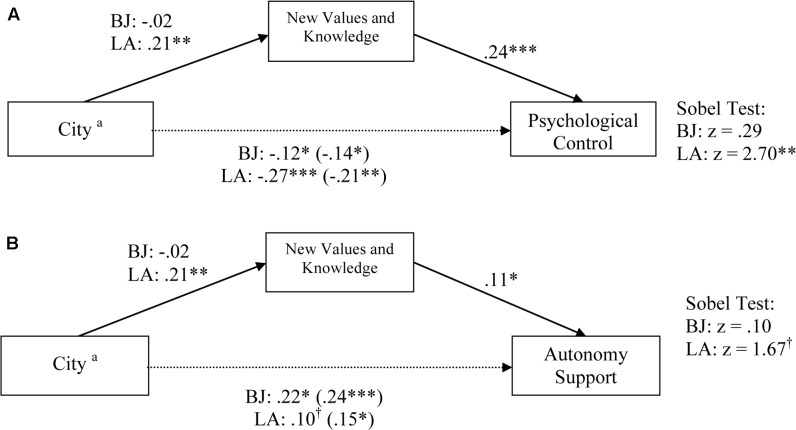
(A) New values and knowledge as a suppressor of the group differences in psychological control in Los Angeles. (B) New values and knowledge as a partial mediator of the group differences in autonomy support in Los Angeles. Reference group: aHong Kong. Child sex, child age, mother age, and maternal education level were entered into the model as covariates. †p < 0.06, ∗p < 0.05, ∗∗p < 0.01, ∗∗∗p < 0.001.